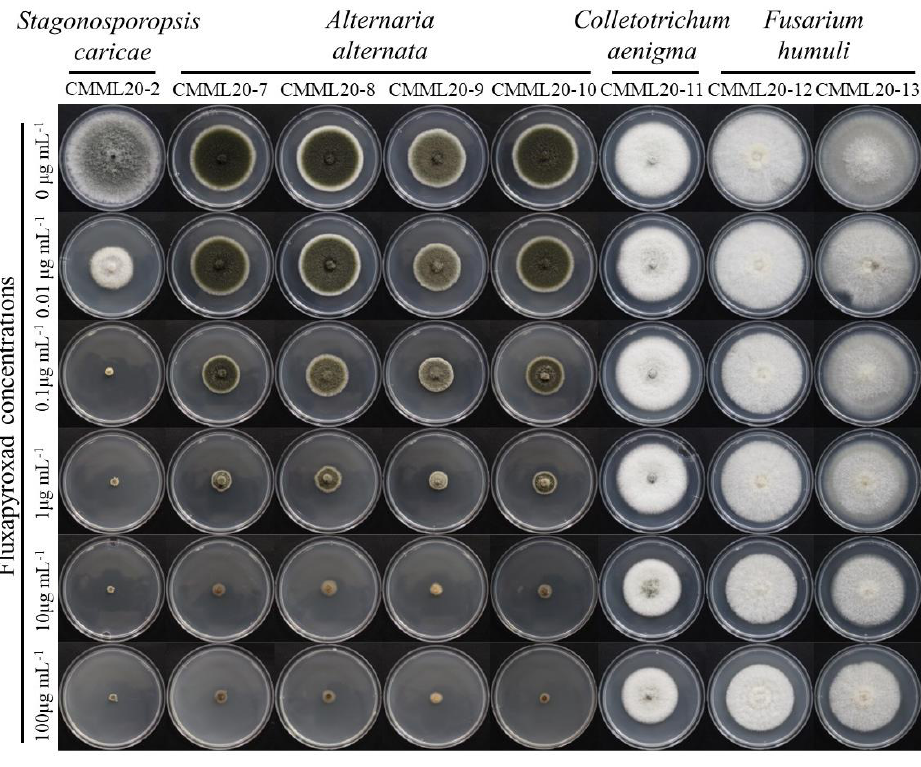
Figure 10. Anterior view of colonies of all fungal isolates on non-supplemented PDA and supple- mented with 0.01, 0.1, 1, 10, or 100 µ g mL − 1 of fluxapyroxad. Table 1. Fungicide sensitivity of all fungal isolates and their EC 50 value calculated in a plate assay. The fluxapyroxad showed effective control activity against the pathogens but not endophytes iden- tified in this study. Different letters indicate statistically significant difference of the values.